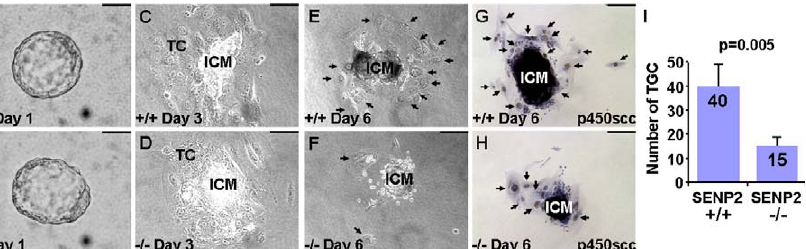
Figure 5. In Vitro Differentiation of SENP2-Null Blastocysts into Trophoblast Cells Is Defective (A–H) Isolated SENP2 þ / þ (A) and SENP2 –/– (B) blastocysts were cultured for trophoblast differentiation in vitro. Images were taken at culturing day 1 (A,B), day 3 (C,D) and day 6 (E–H). TS cells, outgrowing from the trophectoderm, differentiated into a single trophoblast cell (TC) layer, whereas the ICM formed aggregates and sat on top of the trophoblast cells (C,D). Arrows indicated TGCs present in the cultures (E,F). The cultures were then analyzed by immunostaining of a trophoblast specific marker p450scc (brown) and counterstaining of hematoxylin (blue) on day 6 (G,H). (I) The graph represents the average number of TGC present in the SENP2 þ / þ and SENP2 –/– cultures ( p ¼ 0.005, n ¼ 6). Scale bars, 200 l m (E–H); 100 l m (C,D); 50 l m (A,B).